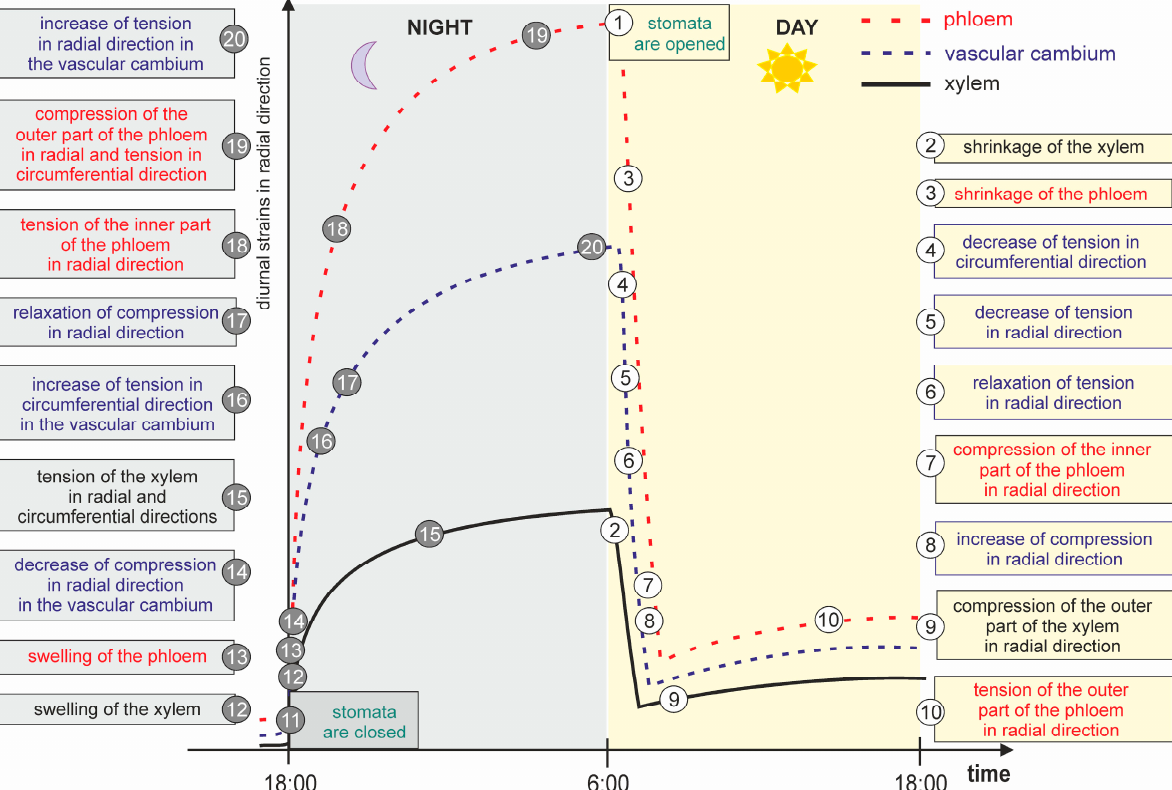
Figure 5. Generation of plant tissue strains in the tree trunk in the radial and circumferential directions due to the opening and closing of stomata in a diurnal rhythm. Tensile strains in the radial direction in the vascular cambium are generated by the swelling of the phloem at night, while compressive strains in the vascular cambium are caused by the shrinking of the phloem during the day (the scheme is an original development of the idea presented by Kojs and Rusin 2011 [134]).